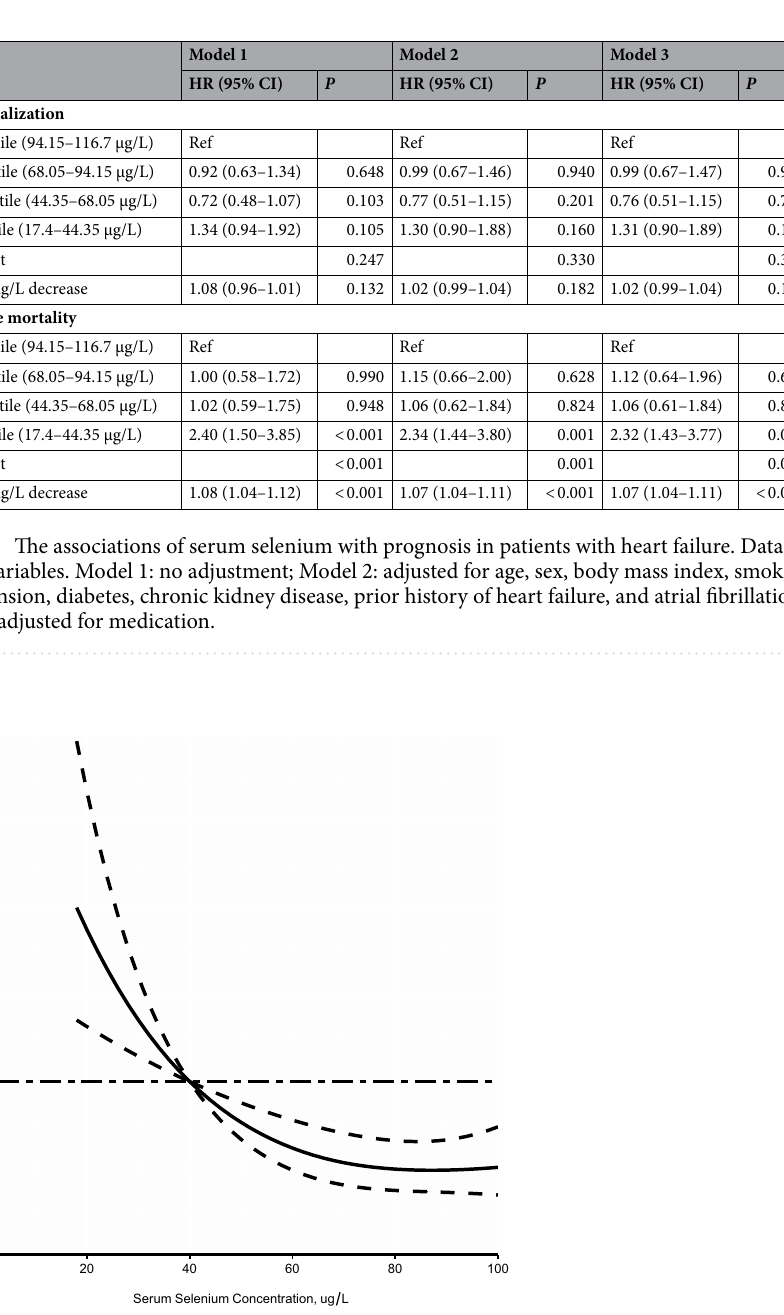
Figure 2. Shapes of the concentration–response relationships of serum selenium and risk of